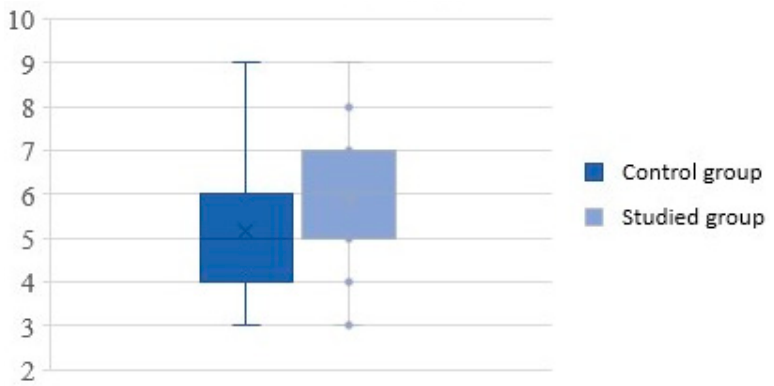
Figure 1. Severity of rhinosinusitis on the visual analog scale.